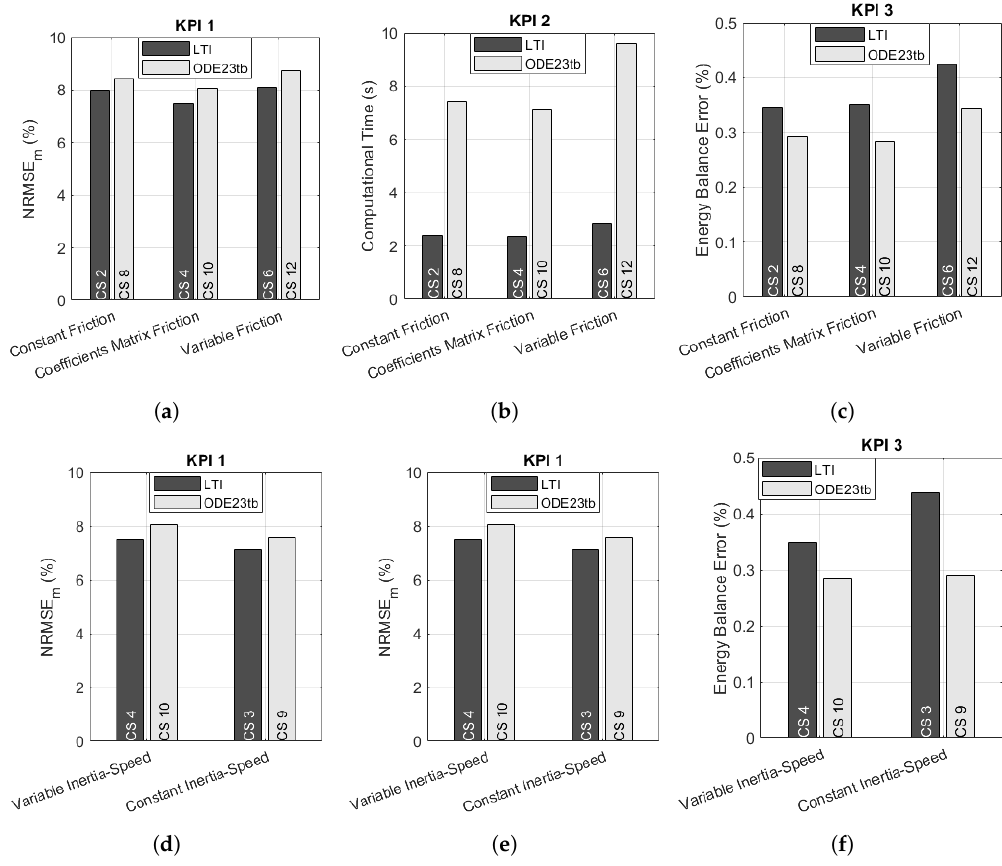
Figure 10. Engine friction submodel comparison of ( a ) KPI 1, ( b ) KPI 2 and ( c ) KPI 3. Inertia-speed approaches comparison of ( d ) KPI 1, ( e ) KPI 2, and ( f ) KPI